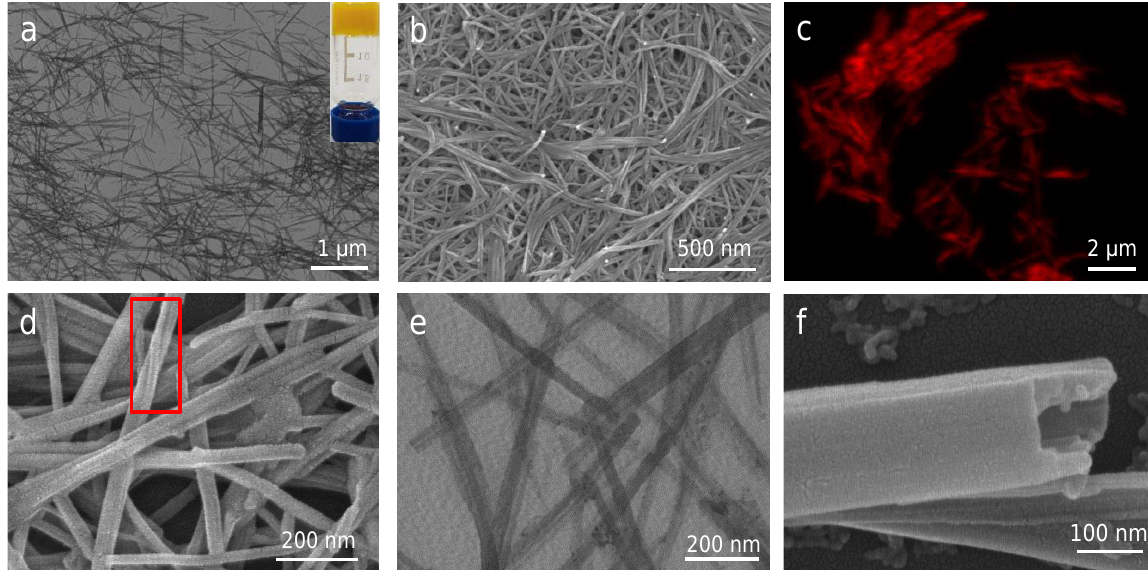
Figure 2. ( a , e ) TEM, ( c ) CLSM, and ( b , d , f ) SEM images of the hollow tubes of 8 mM Ag 9 -NCs/0.3 M L–MA hydrogel with different magnifications (the inset of a is a photograph of the hydrogels).